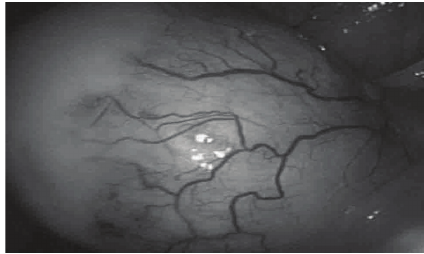
Figure 2: Laparoscopic view of appendiceal mucocele.